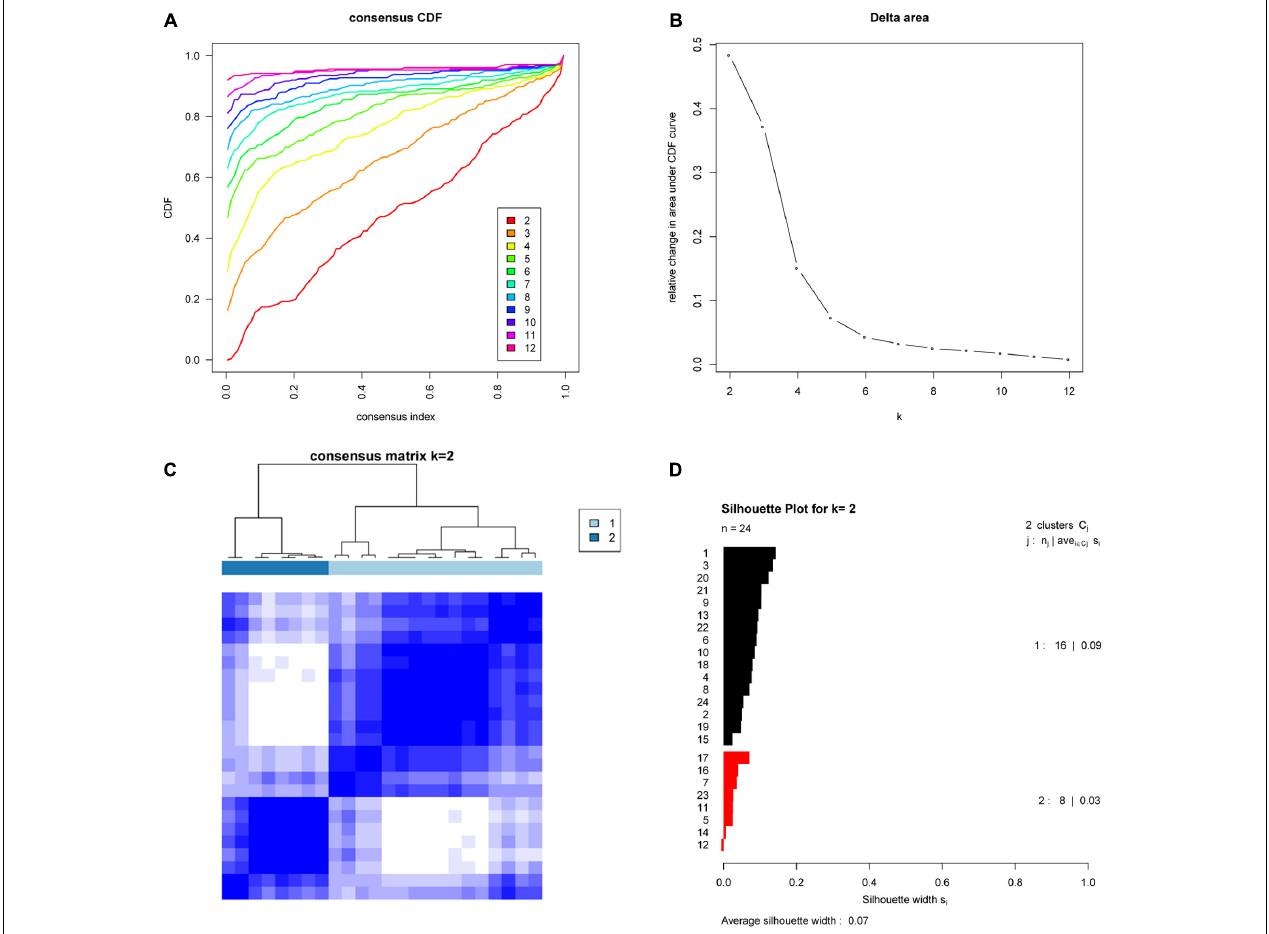
FIGURE 2 | Validation of molecular subtypes of EAC in the GSE32507 cohort (Validation cohort). Empirical cumulative distribution plot (A) and Relative increase in the area under the CDF curve (B) in molecular subtypes of GSE32507; Consensus Clustering matrix (C) and Silhouette analysis (D) of the two subtype of